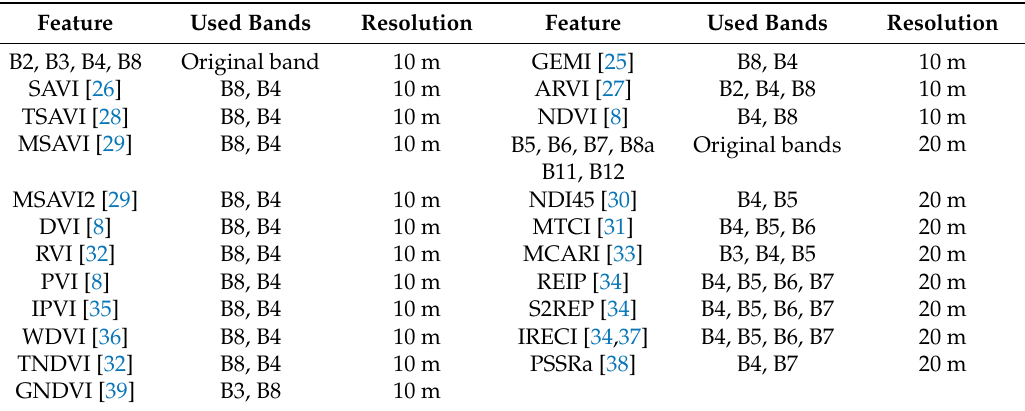
Table 2. Sentinel-2 spectral